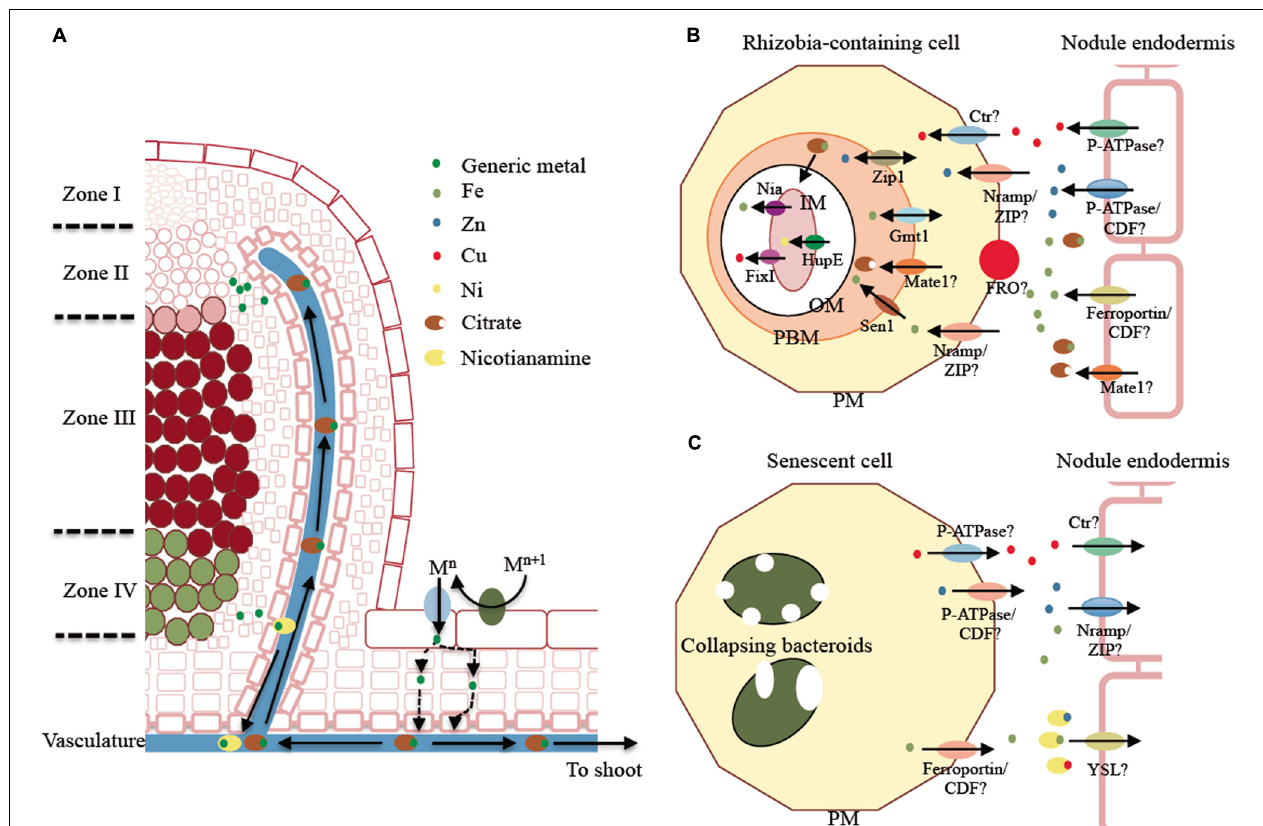
infected cell. In zone IV (senescence zone), metals are released to the apoplast, associated with nicotianamine, and translocated into the vasculature. (B) Proposed model of metal delivery from the vasculature to zone II. Proposed transporter families to carry out ion transport are indicated with a question mark. (C) Proposed model of metal recovery from the senescent zone of the nodule. Proposed transporter families are indicated with a question mark. PM indicates plasma membrane; PBM, peribacteroid membrane; OM, bacterial outer membrane; and IM, bacterial inner